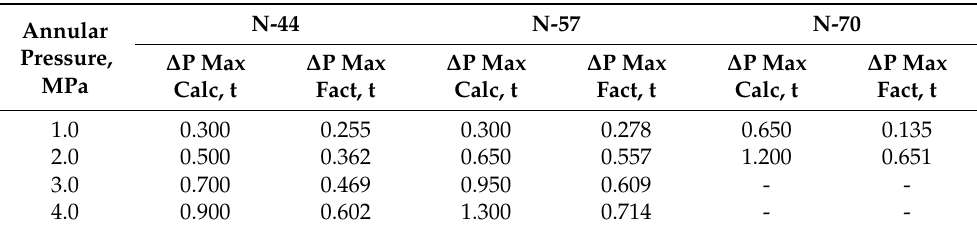
Table 1. Correlation of maximum load growth on the rod string with a pump’s type and size and pressure variation in the annular space.